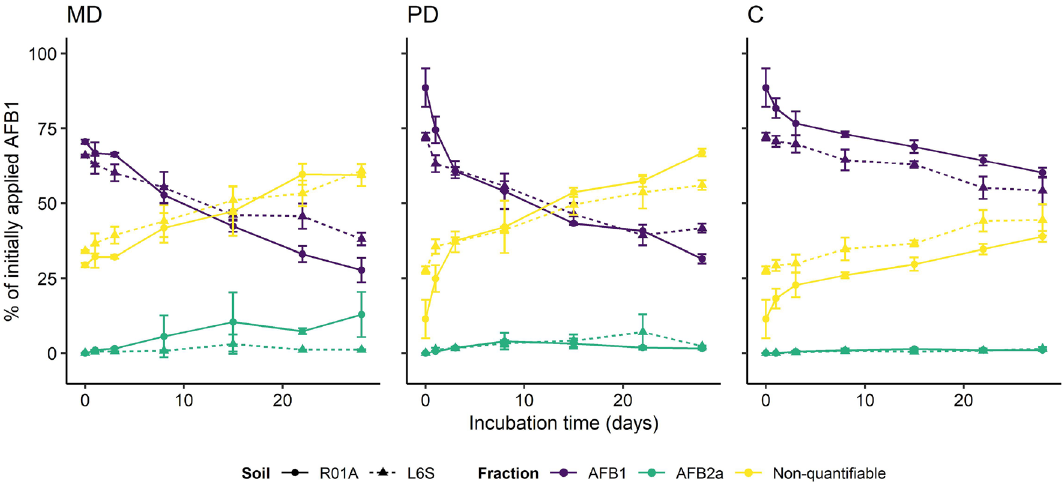
Figure 3. Processes of AFB1 dissipation for the sandy loam soil (“R01A”) and clay soil (“L6S”) incubated (28 days) under dark-abiotic (C), UV irradiated (PD) and nonsterile (MD) conditions. Extractable AFB1 (purple), extractable AFB2a (cyan) and non-quantifiable (yellow) fractions are given as percentage of initially applied AFB1. Results are expressed as mean ± standard deviation (n =